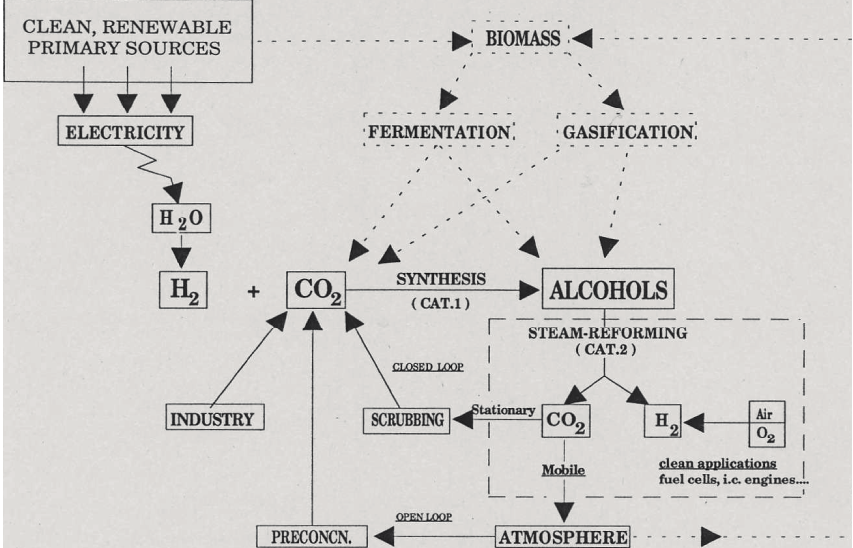
Figure 1. Idealized energy scheme based on renewable H 2 stored in simple alcohols (reproduced from [19] with